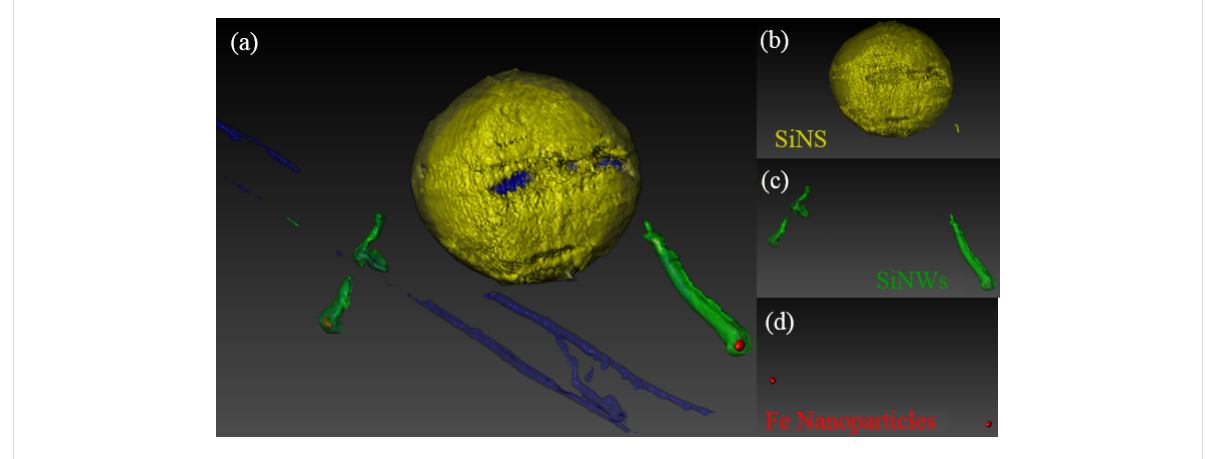
Figure 3: (a) Volume reconstruction of the system formed of (b) a SiNS and (c) two SiNWs having a Fe nanoparticle at the top, as illustrated in (d).